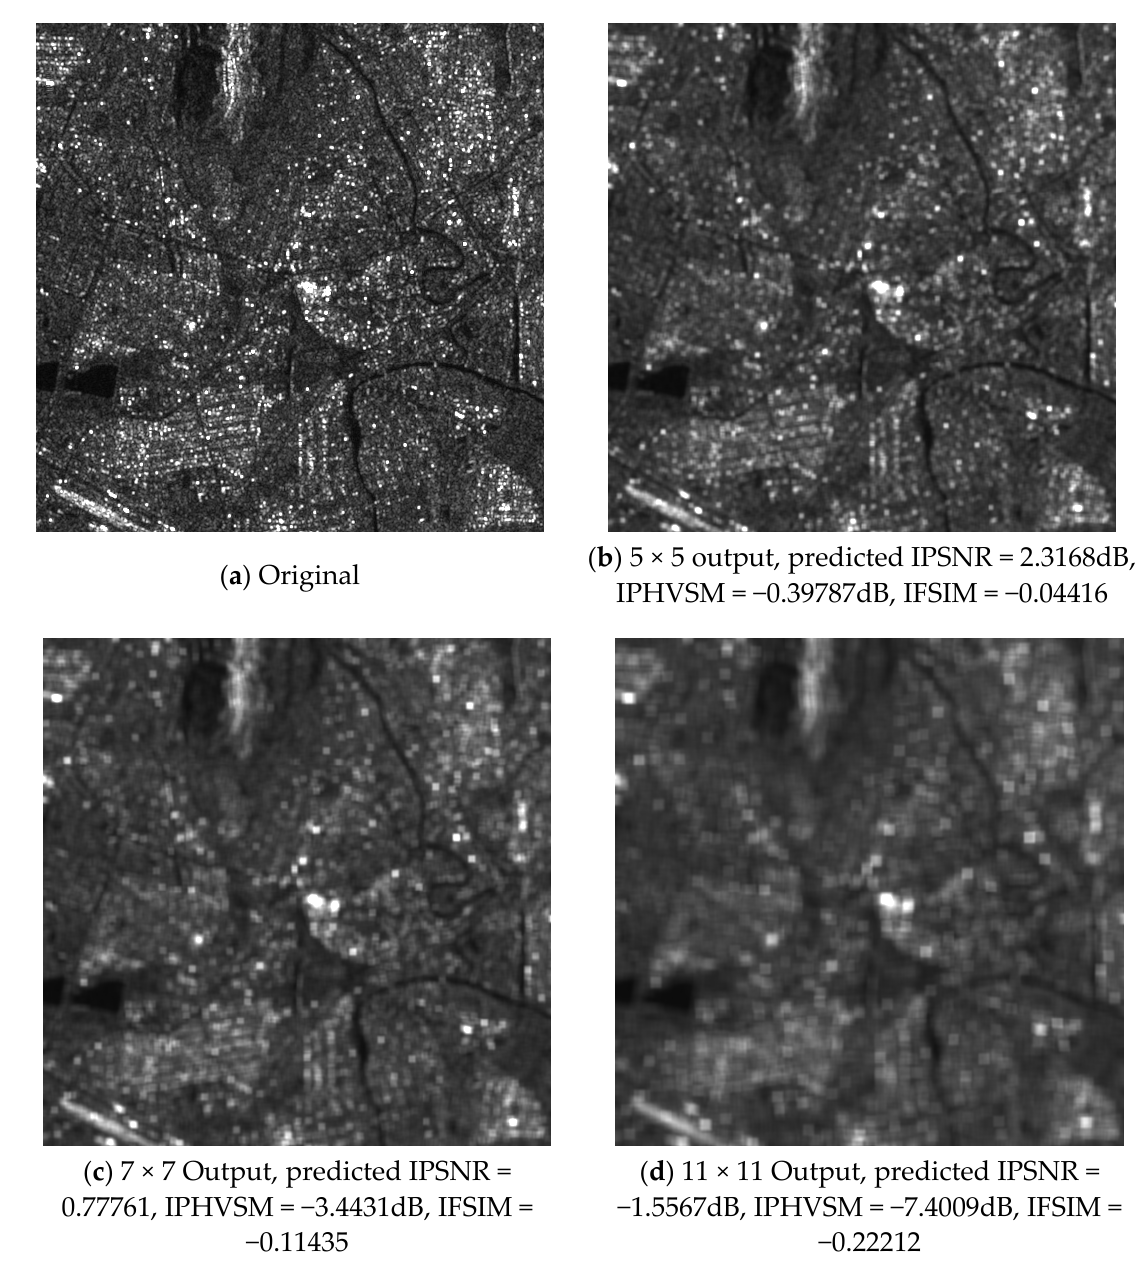
Figure 20. The original Sentinel-1 image ( a ); and the outputs of the 5 × 5 ( b ); 7 × 7 ( c ); and 9 × 9 ( d ) Lee filters.